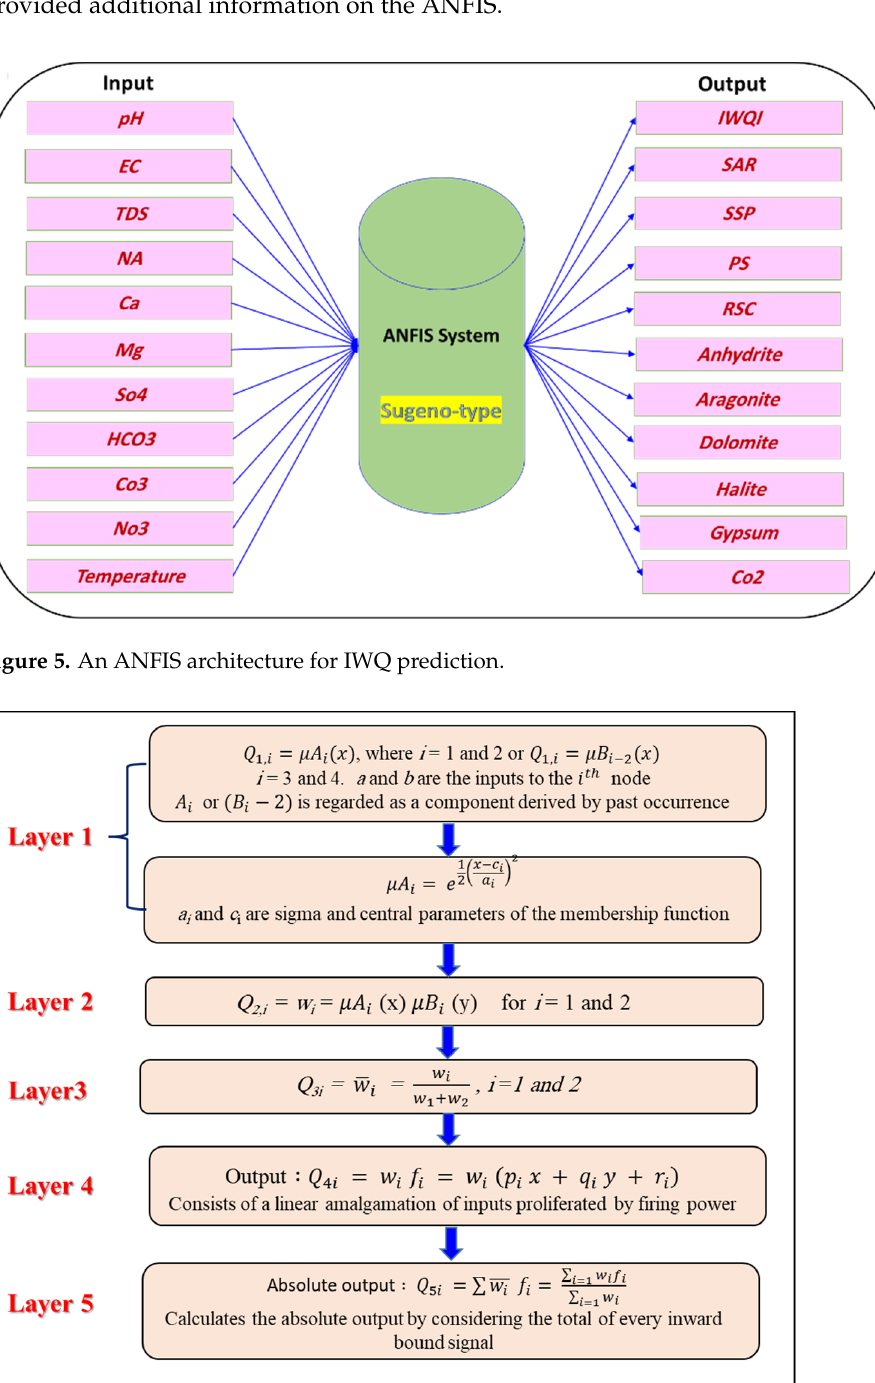
Figure 6. C onceptual illustration of the fi ve layers that comprise ANFIS. Figure 6. Conceptual illustration of the five layers that comprise